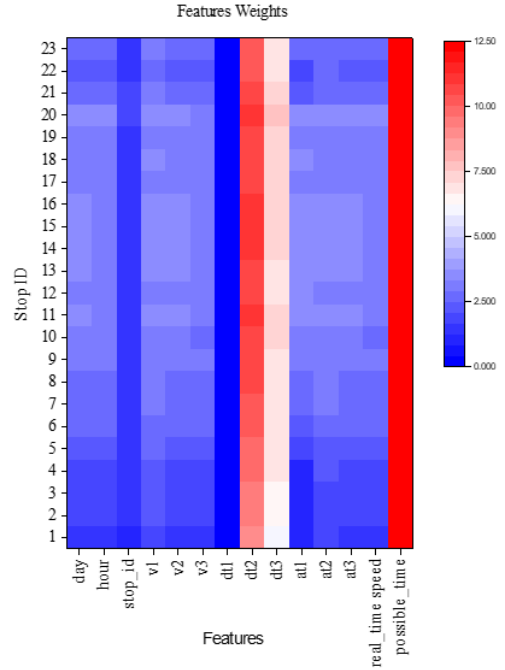
Figure 9. Average features weighting matrix.